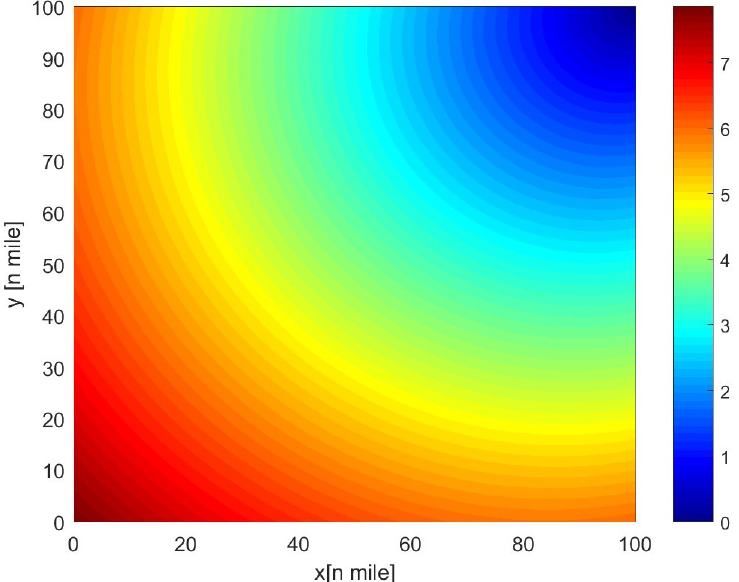
Figure 3. Two-dimensional guidance